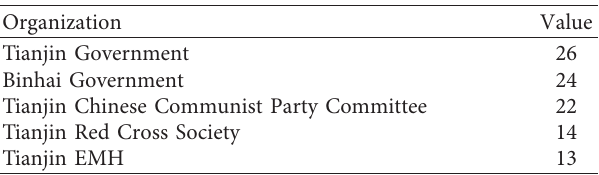
Table 5: Indegree centrality ranking (top 5 scorers) in Tianjin Port blast response network.